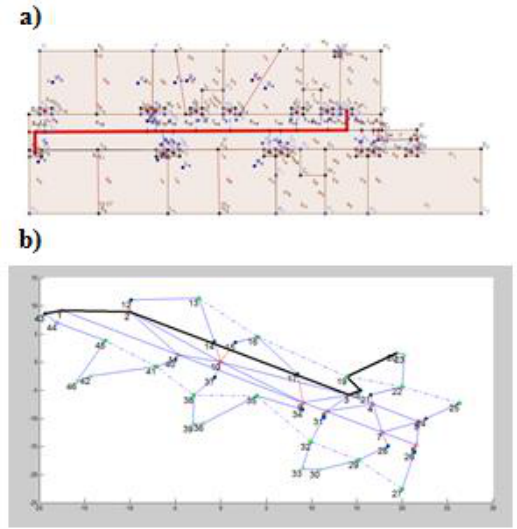
Figure 10. Dijkstra’s algorithm for shortest path finding where a) red line represents optimal route between two dual nodes b) black line represents optimal route between two dual nodes while corridor is divided into several regions